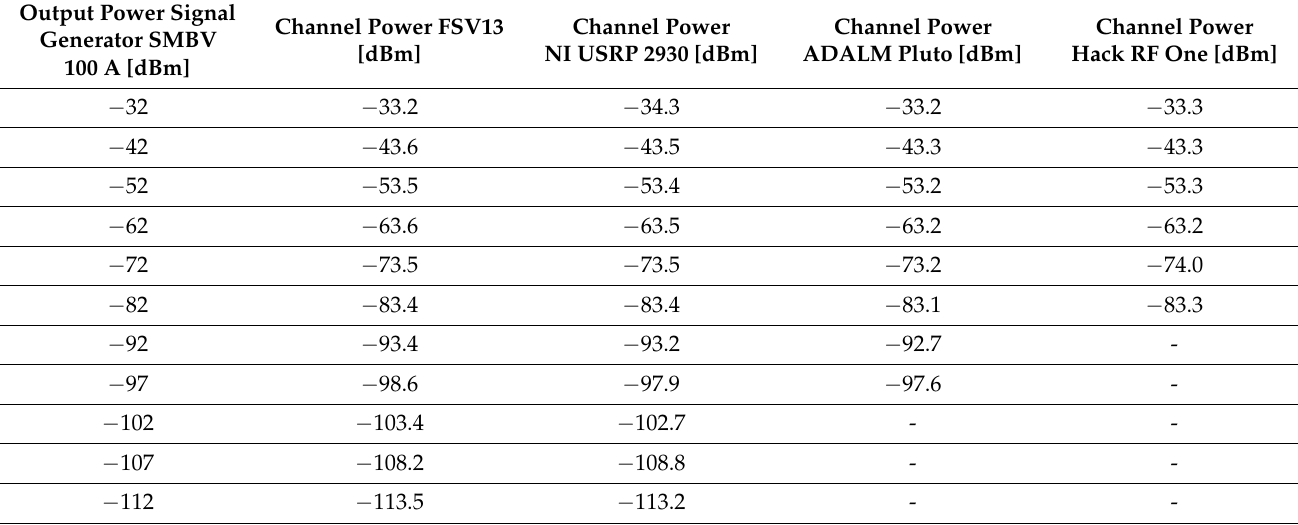
Table 2. The dynamic range of the amplitude for an emitted TETRA channel signal varying between − 112 dBm and − 32 dBm (channel no. 131, central frequency 393.2875